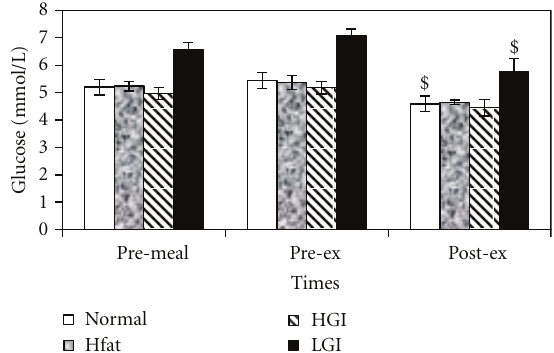
Figure 4: Mean ( ± SE) plasma glucose concentrations at pre-meal, pre-exercise and, post-exercise for four trials. $ indicates significant di ff erence with postprandial values.